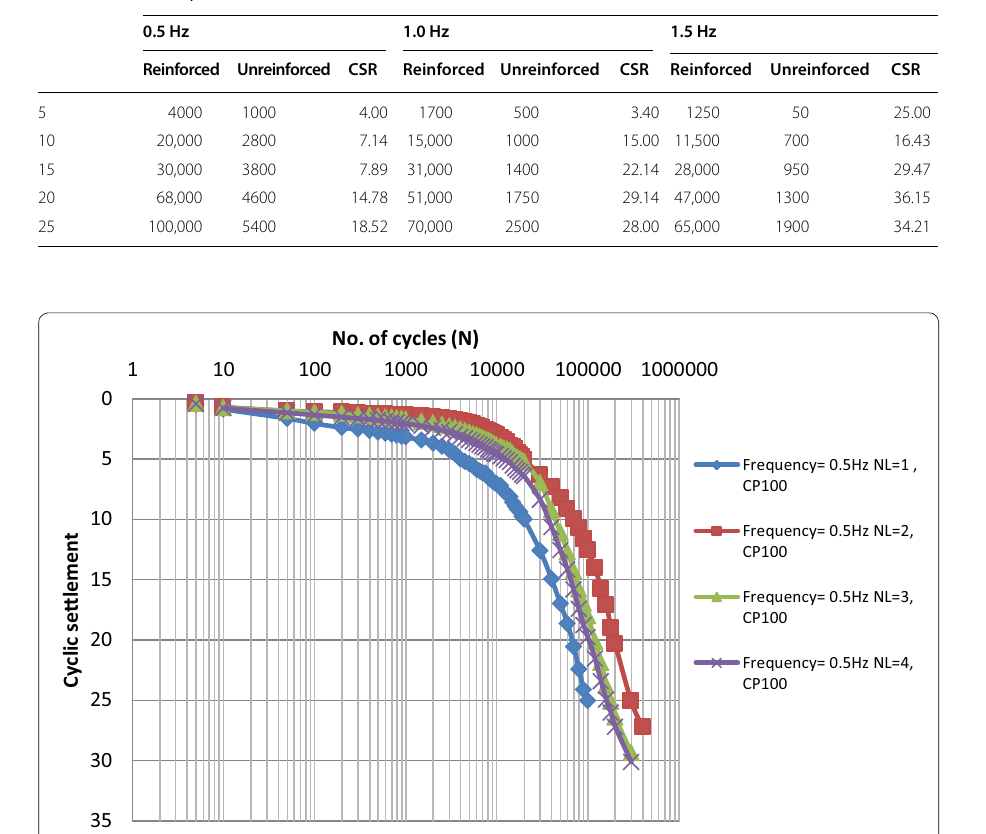
Fig. 5 Variation of cyclic settlement with number of cycles for different layer configuration at CP and F 0.5 =